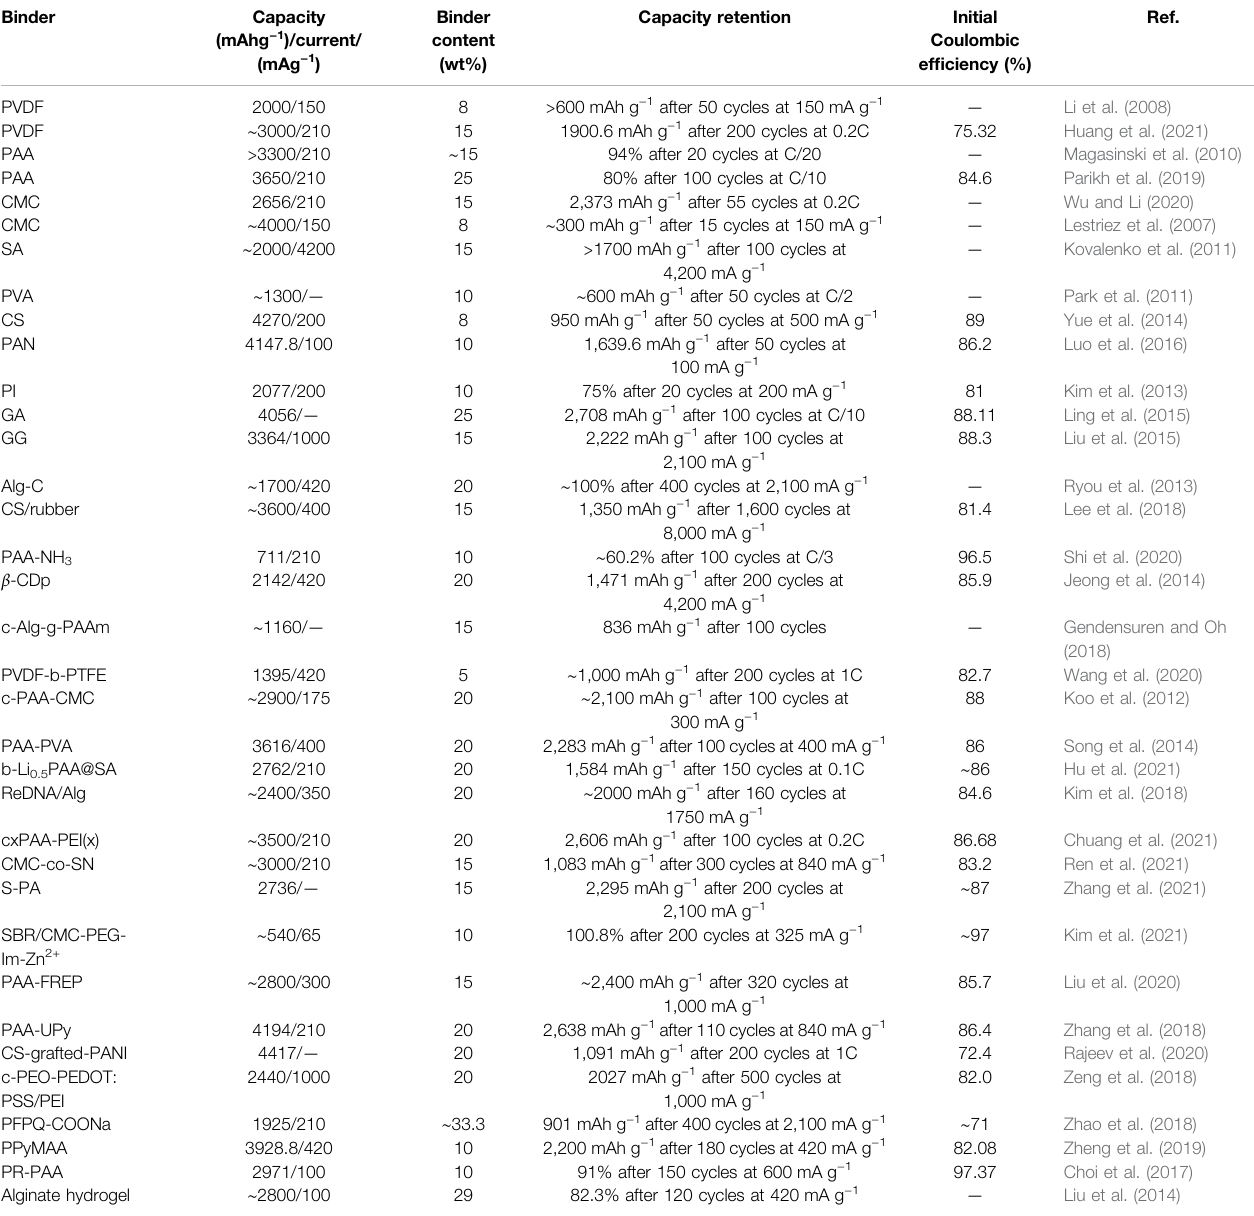
TABLE 2 | The electrochemical performances for Si-based anodes with various binders.